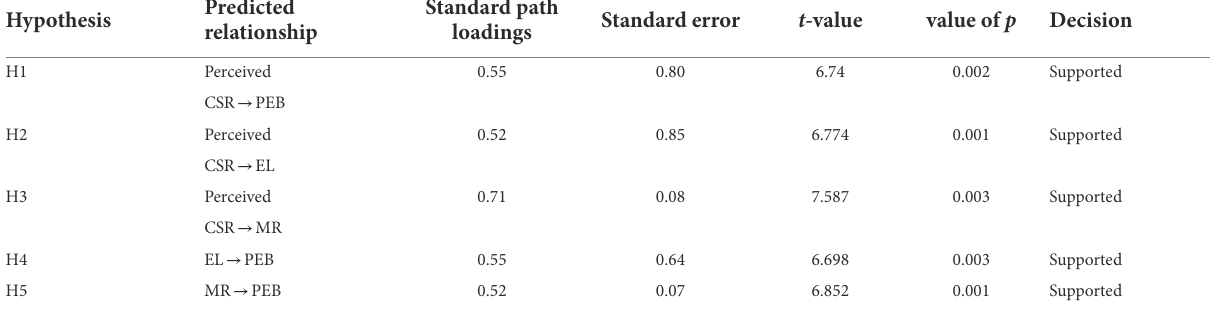
TABLE 8 Regression results of the structural model and hypotheses test outcomes.